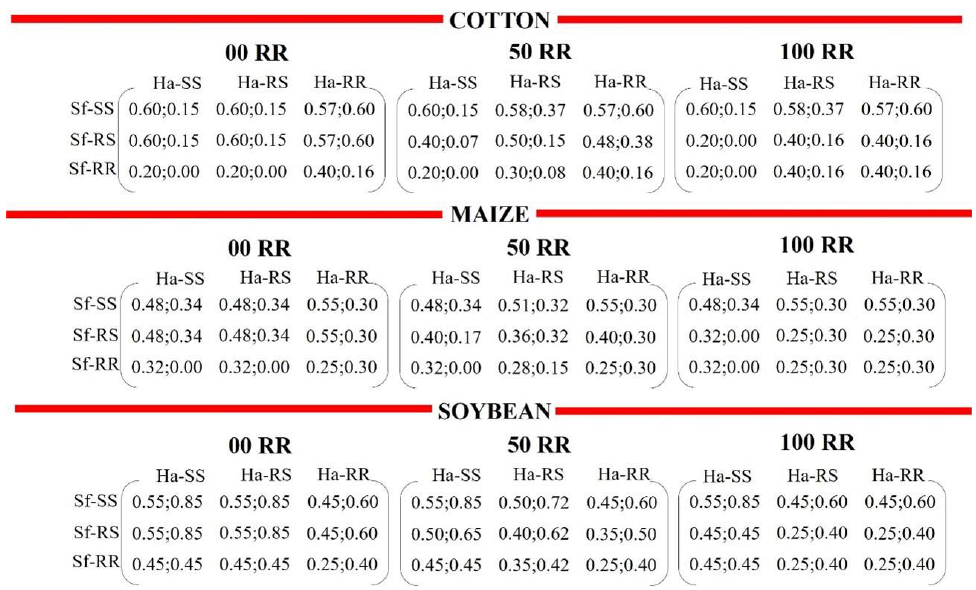
Figure 1. Matrices containing the survival probabilities of susceptible (SS), heterozygous (RS), and resistant (RR) strains of Helicoverpa armigera (Ha) and Spodoptera frugiperda (Sf) in cotton, corn, and soybean plants. The matrices represent the payoffs given the interspecific interactions. Data before the semicolon in each cell correspond to the survival of S. frugiperda , while the data after the semi- colon are from H. armigera : 100 RR, competition behavior of heterozygous strain 100% equal to the behavior of the resistant homozygous strain; 50 RR, intermediate behavior of heterozygous strain between susceptible and resistant homozygotes; 00 RR, homozygous behavior of heterozygous strain 100% equal to the susceptible homozygote.